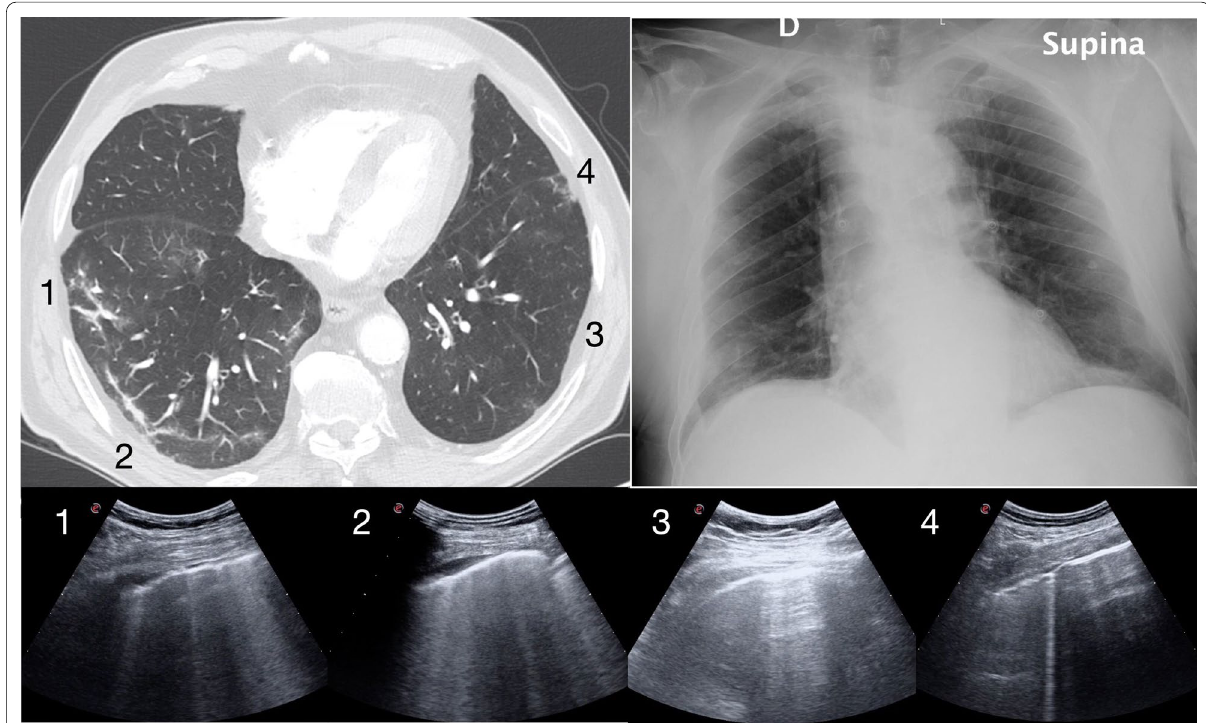
Fig. 3 The case of an otherwise healthy 77-year-old man complaining of fever and cough for 7 days ( mild phenotype ). LUS and CXR were in disagreement. LUS showed a high probability pattern for COVID-19 pneumonia. The LUS scans reported in the bottom show the patchy and bilateral distribution of clusters of B-lines and light beam (1, 2, 4) with some irregularity of the pleural line (1, 4), alternating with normal A-lines pattern (3). CXR in the upper right panel was read negative . Corresponding CT scan in the upper left panel shows bilateral GGO and was considered typical appearance . The points numbered in the CT image correspond to the 4 LUS scans. Viral RT-PCR was positive. LUS Lung Ultrasound, CXR Chest Radiography, COVID-19 Corona Virus Disease 2019, GGO Ground Glass Opacity, CT Computed Tomography, RT-PCR